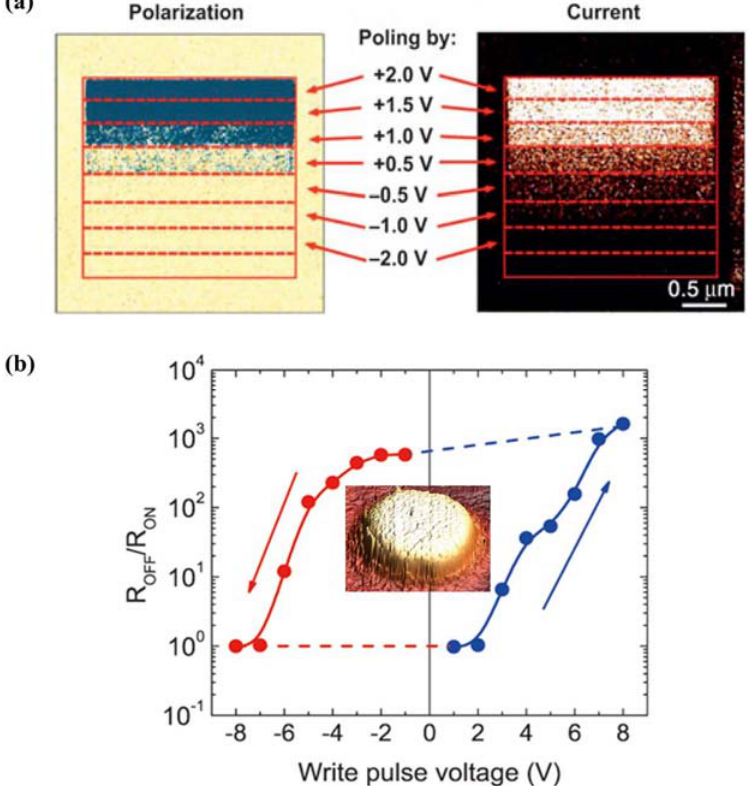
Figure 14. ( a ) Spatially resolved correlation between the onset of polarization reversal and a change in electrical conductance in BaTiO 3 thin film grown on SrRuO 3 /SrTiO 3 (Tsymbal et al. [382]); ( b ) R OFF /R ON as a function of the writing pulse amplitude (pulse width is 1 ms) for the 4 u.c. thick BaTiO 3 junctions, with topography of the junction in the center (Kim et al.